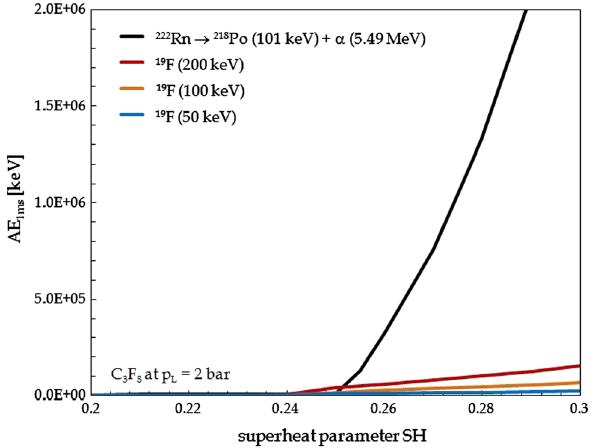
Fig. 10 Distributions of AE 1ms vs. SH for alpha decays and nuclear recoils in C 3 F 8 at p L = 2